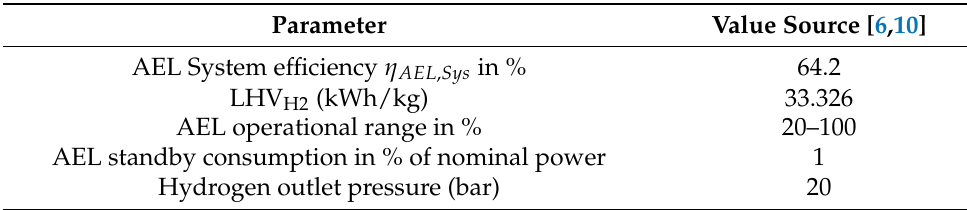
Table 3. Technical assumptions for the alkaline electrolyser system